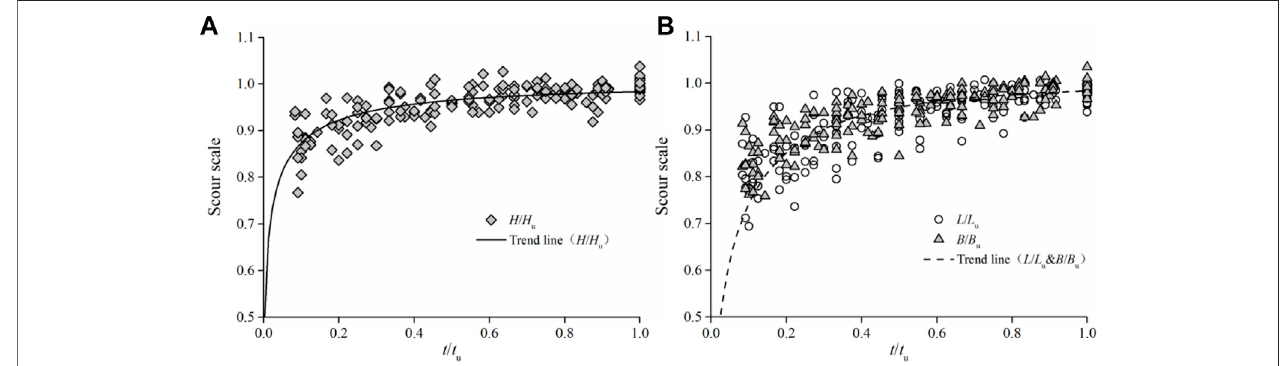
FIGURE 6 | Prediction of the time-domain scour process: (A) H / H u ; (B) L / L u and B / B u .